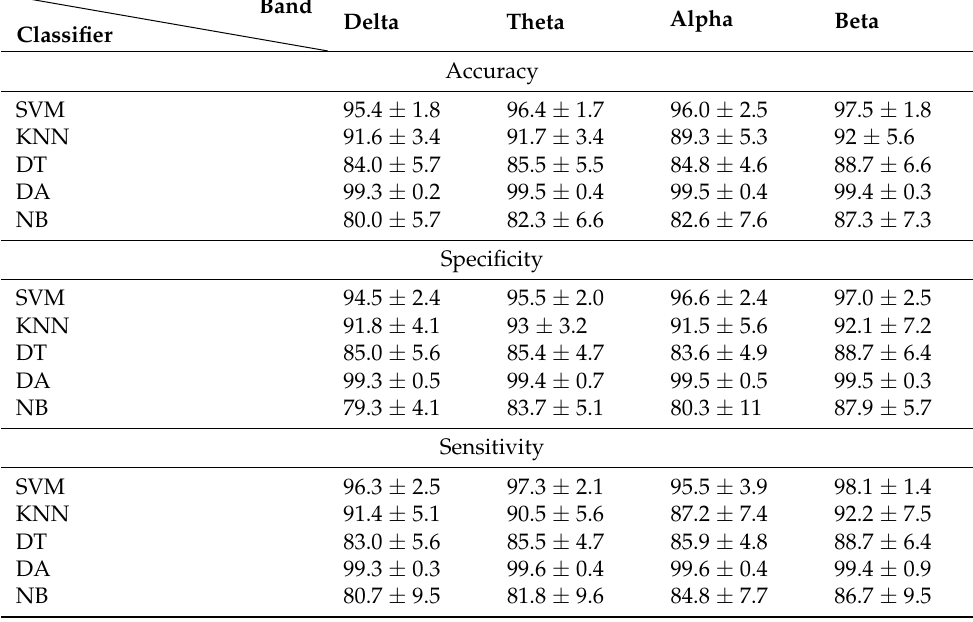
Table 1. The accuracy of subject-independent Fast-ICA-cleaned EEG-based vigilance classification. Classifier